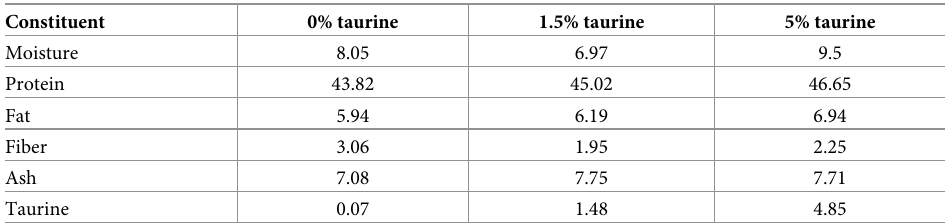
three standard metrics of retinal function: (1) luminous sensitivity (V log I response), (2) flicker fusion frequency (FFF, a measure of temporal resolution), and (3) spectral sensitivity. Anesthesia and handling methodologies were as described previously (32–35). Teflon-coated, silver–silver chloride, 0.5 mm diameter wire electrodes were used to measure ERG responses to light stimuli. The active electrode was placed on the corneal surface and the reference elec- trode in the nasal cavity. All subjects were dark-adapted for a minimum of 60 minutes prior to visual trials. Electrode placements, as well as any further modifications to the experimental setup, were conducted under a dim red LED light source (peak wavelength of 660 nm) which we presumed would be well beyond the spectral sensitivity of European sea bass, as it is in a variety of inshore temperate teleost fishes [32–35]. Luminous sensitivity was assessed using stimulus intensities covering six orders of magni- tude using a collimated white LED source and neutral density filters progressing from sub- threshold to saturation intensity levels in 0.2 log unit steps. FFF was assessed by measuring the ability of the retinal responses to track sinusoidally modulated white light stimuli ranging in frequency from 1 Hz (0 log units) to 100 Hz (2.0 log units), presented in increments of 0.2 log unit frequency steps. FFF was measured at stimulus intensities required to produce responses 25%, 50% and 100% of the maximum response, as well as fixed light levels (log I = 1.9, 2.7, and Table 2. Proximate composition (%) of three experimental diets as fed.